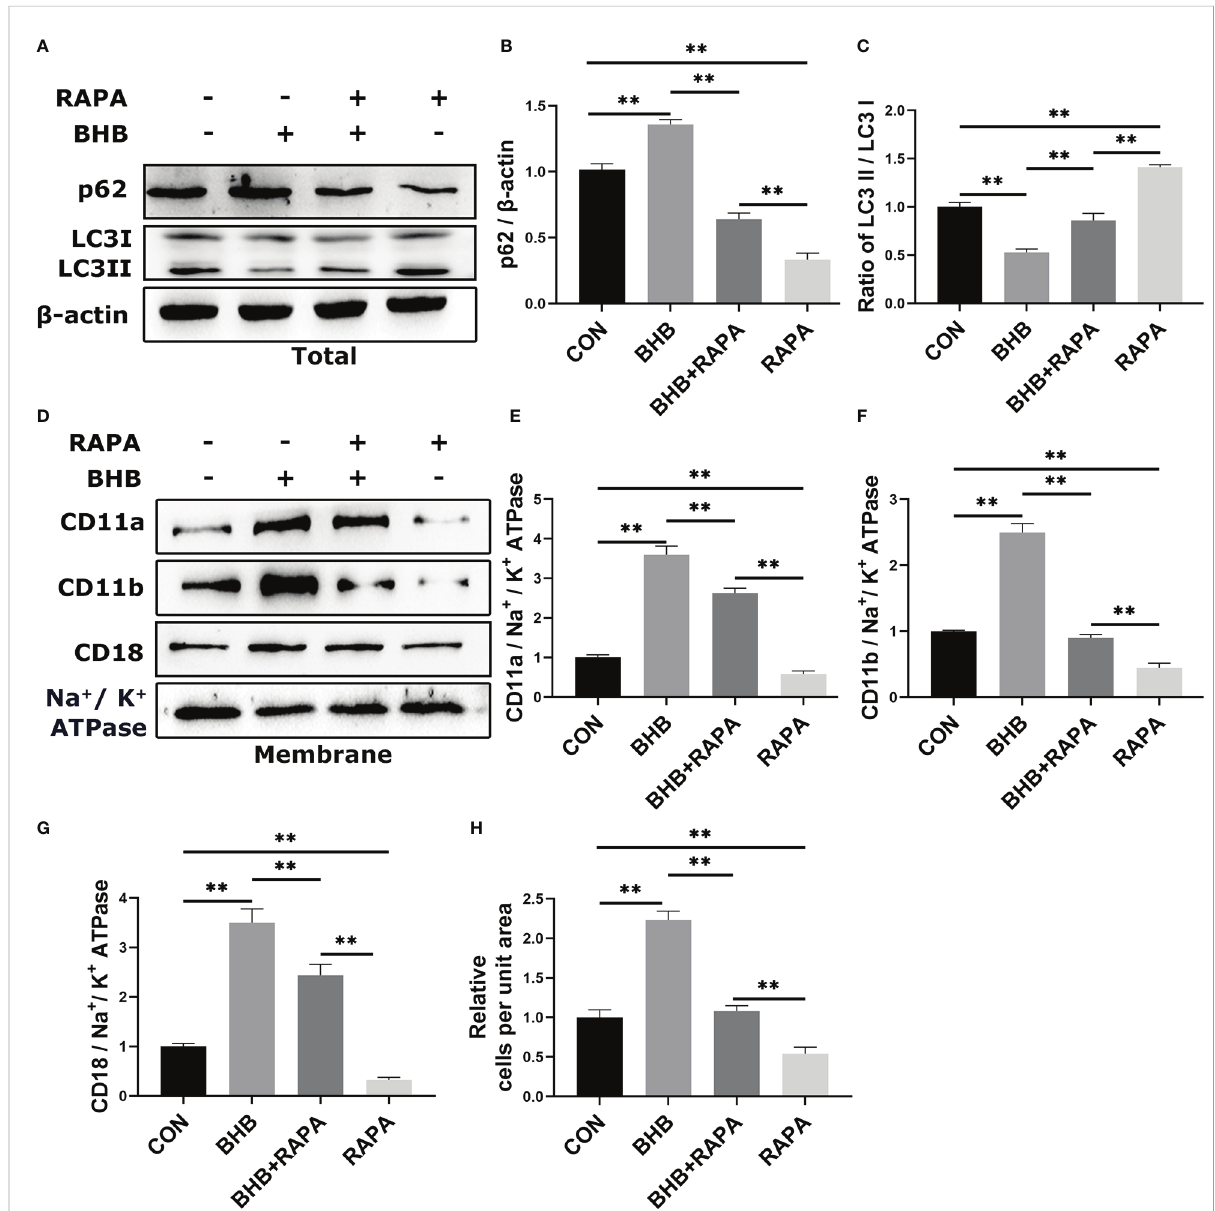
FIGURE 4 Role of autophagy in BHB promoting adhesion of bovine neutrophils. Rapamycin (100 n M , 2 h) was used to activate autophagy. (A-C) Protein abundance of p62 and LC3. Representative blots in both groups were shown in A. The quanti fi cation was shown in B-C. (D-G) Protein abundance of membrane CD11a, CD11b, CD18. Representative blots in both groups were shown in D. The quanti fi cation was shown in E-G. (H) Quantitation of the number of adherent neutrophils. For WB experiments, b -actin was used to normalize the total protein abundance, while Na +/ K + ATPase was used to normalize membrane protein abundance. Data were expressed as the mean ± SEM. A two-way analysis of variance (ANOVA) was performed to analyze differences between BHB and RARA, including a Bonferroni post-hoc analysis. Two-way ANOVA showed a signi fi cant difference in BHB × RAPA interaction ( P < 0.01), including a Bonferroni post-hoc analysis. ** P < 0.01 as statistically highly signi fi cant. CON, control; BHB, b -hydroxybutyrate; RAPA, rapamycin; p62, sequestosome-1; LC3, microtubule associated proteins 1A/1B light chain 3; CD11b, integrin alpha-M precursor; CD11a, integrin alpha-L precursor; CD18, integrin beta-2 precursor; SEM, standard error of the